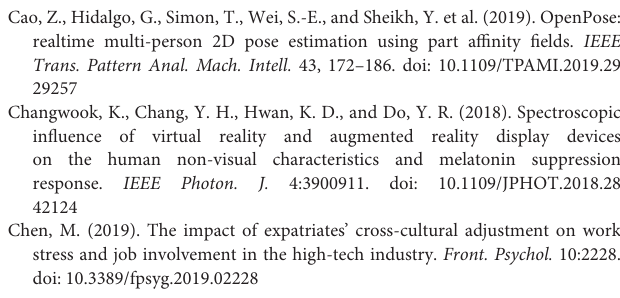
the Open Pose’s 68.7 and 75.4 mm. It indicates that the proposed algorithm is more efficient and convenient in